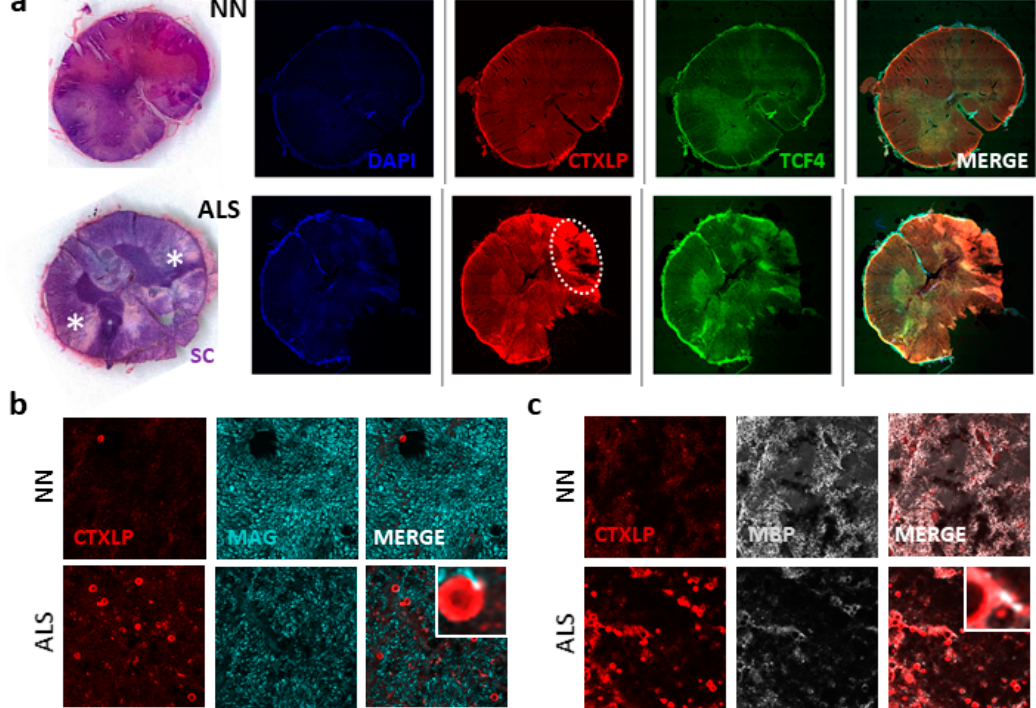
Figure 6. ERVK CTXLP protein expression is associated with demyelinated lesions in spinal cord tissues from patients with ALS. ( a ) ERVK CTXLP levels are enhanced in autopsy lumbar spinal cord tissues from patients with ALS, as measured by light and confocal microscopy. Representative 10 × confocal micrographs of ERVK CTXLP expression in ex vivo lumbar (LC) spinal cord of a neuro-normal control (NN, n = 5), and patients with ALS ( n = 5). Solochrome cyanine (SC) stain (purple) with eosin counterstain (pink) depicts tissue myelination; pale lesions appear in ALS tissues (as indicated by an asterisk). These lesioned areas exhibited increased CTXLP protein expression (red). Oligodendrocyte precursor marker transcription factor 4 (TCF4) is in green. DAPI stain depicts cellular nuclei. Note: CTXLP expression occurs in either the lateral (indicated by a white circle) and anterior cortical spinal tracts. ( b ) Myelin protein MAG levels are lower in CTXLP + ALS-lesioned spinal cord tissues ( n = 5), as compared to controls ( n = 5). ( c ) Myelin protein MBP levels are reduced in CTXLP + ALS lesioned spinal cord tissues ( n = 5), as compared to controls ( n = 5). The magnified inset depicts MBP-degraded myelin vesicles (condensed MBP aggregates) in CTXLP-expressing cells, which is indicative of an ongoing neurodegenerative process.